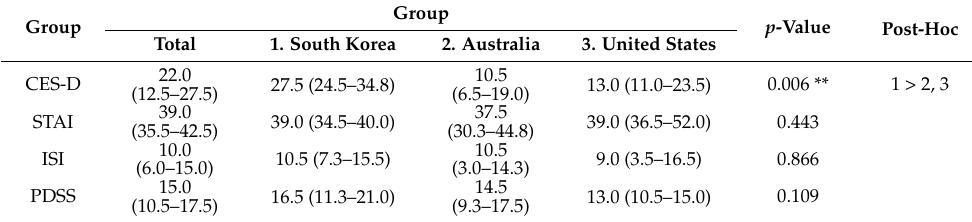
Table 3. Difference between groups in psychological